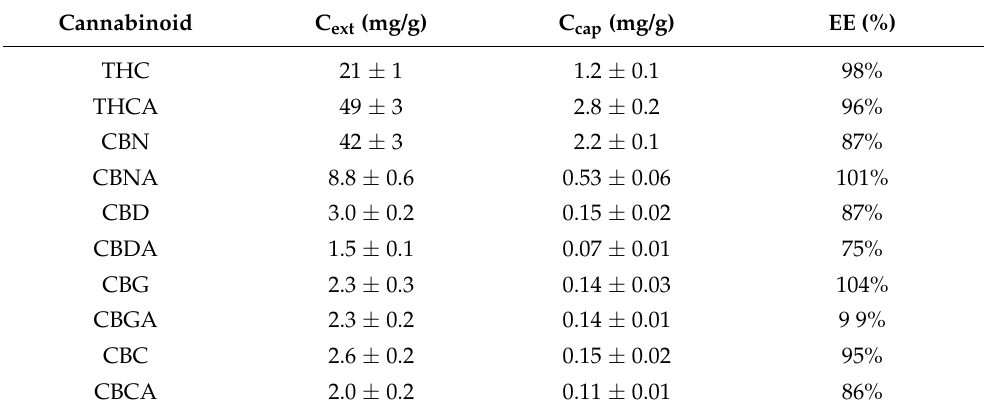
Table 1. Mean concentration of cannabinoids (mg/g) in extract and microcapsules (n = 3, 2 s at 95% confidence level) and encapsulation